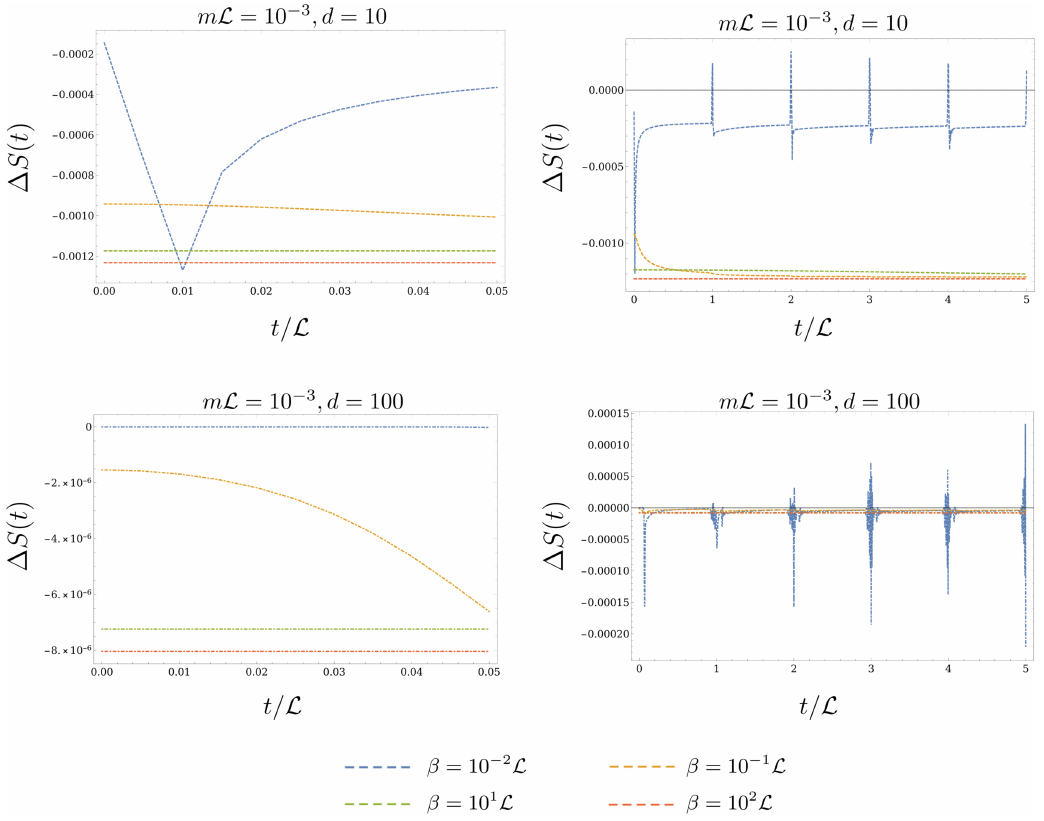
Figure 16 . Temperature effect on time evolution of ∆ S = S OEE − S EE is presented for N =1501 , = N + N =1+1 N A A L 1( R 1) A L 2( R 2) L ( R )